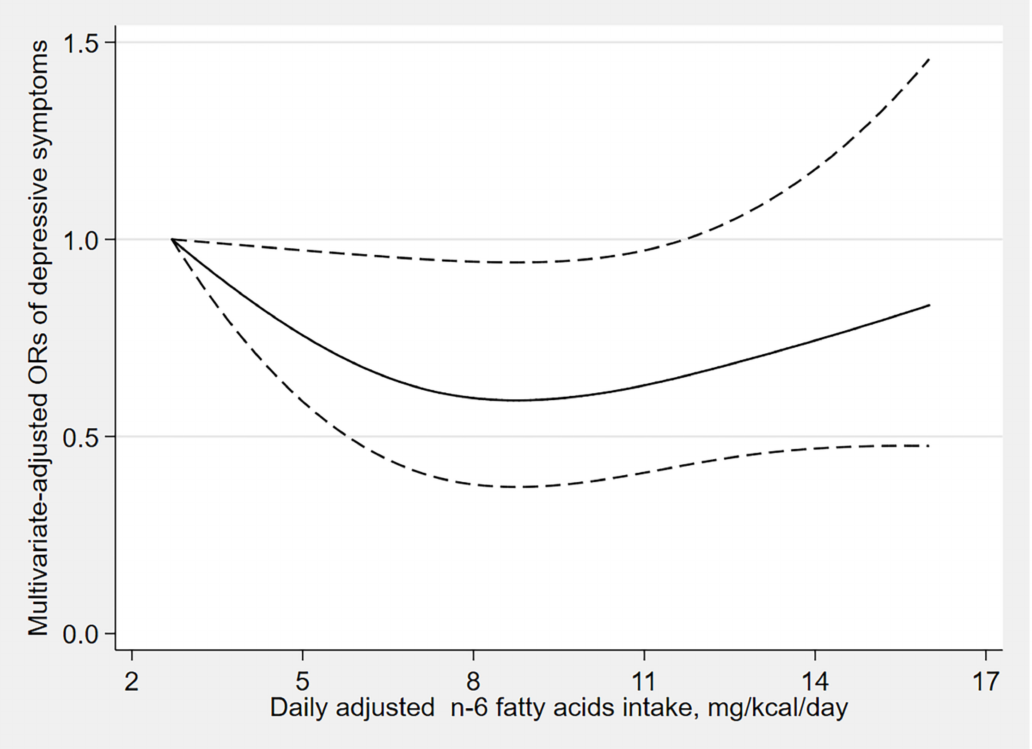
Figure3. Dose–responserelationshipbetweenn-6fattyacidsintakeandtheriskofdepressivesymptoms. The solid line represents the OR values and dashed lines represent the 95% confidence intervals.